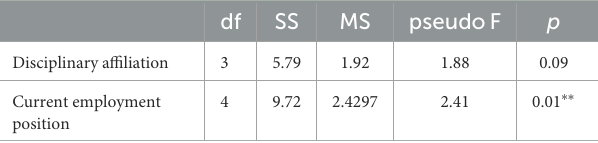
TABLE 6 PERMANOVA over Euclidean distances based on seven problems for nine groups of the variables disciplinary affiliation and current employment